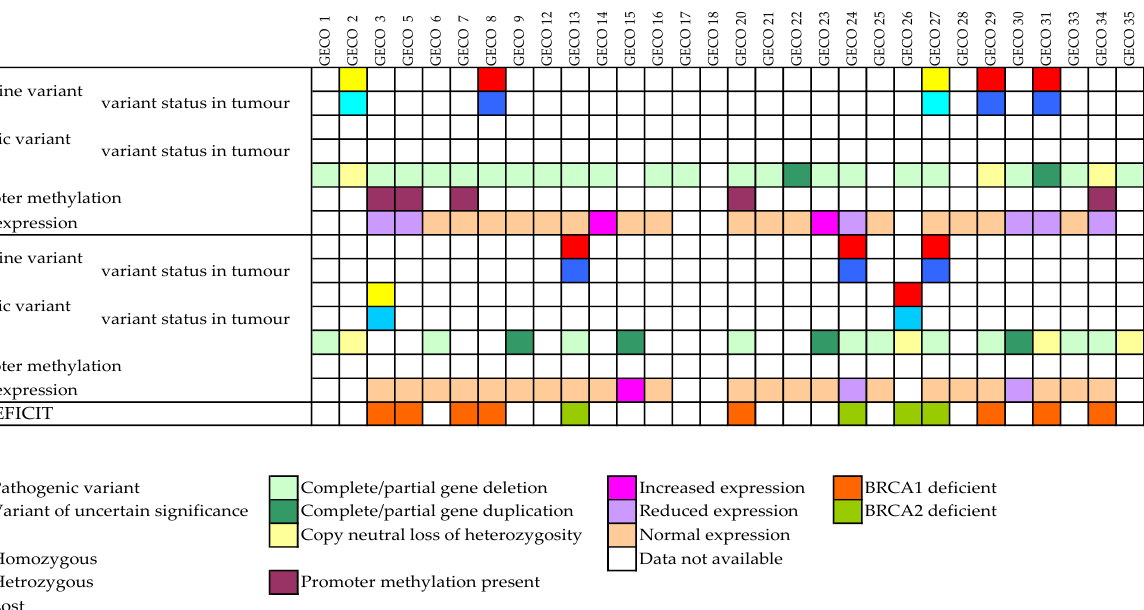
Figure 1. BRCA1/2 characterization in OC samples. SCNA = somatic copy number alterations.